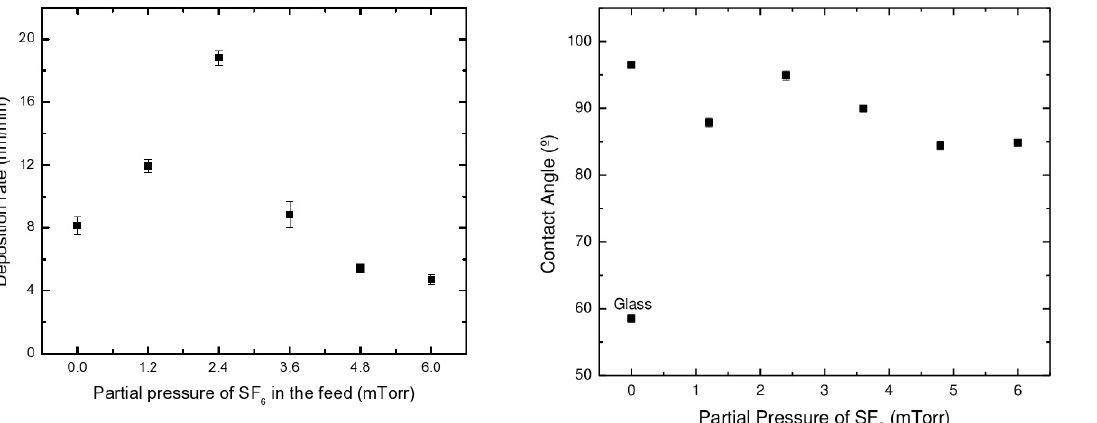
Figure 2. Deposition rate as a function of R for films at increasing values of R